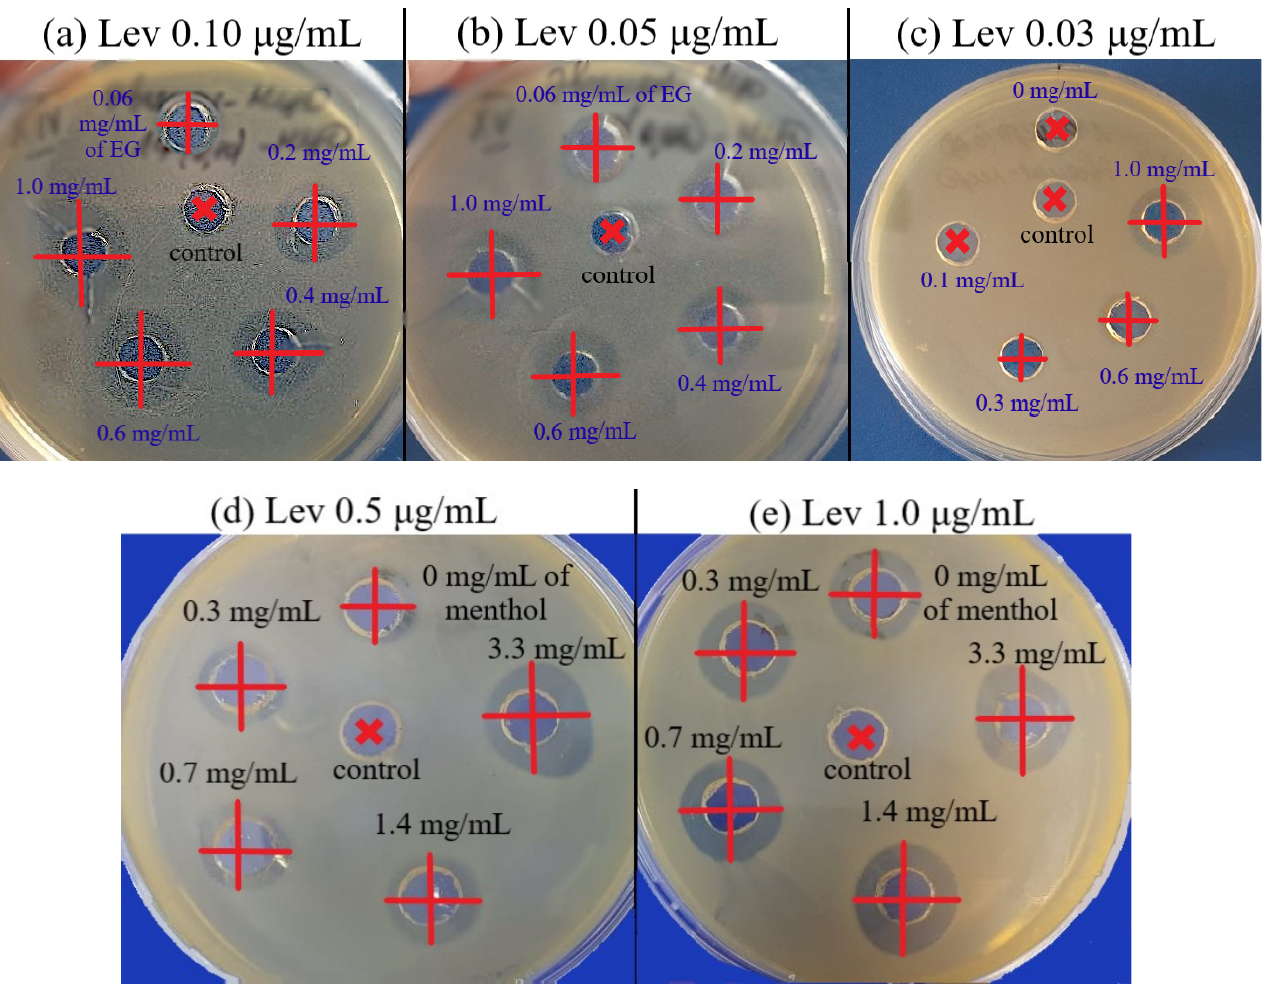
Figure 4 . E. coli growth inhibition by Lev–MCD (1:2), C Lev = 0.10 ( a ); 0.05 ( b ) and 0.03 μ g/mL ( c ) with adjuvant EG–MCD (1:2, the concentrations of EG are indicated in the figure). B. subtilis growth inhibition by Lev–MCD (1:2), C Lev = 0.5 ( d ) and 1.0 ( e ) μ g/mL with adjuvant menthol–MCD (1:2, the concentrations of menthol are indicated in the figure). The molar ratio of the components is given in parentheses. Small bold red crosses refer to the absence of bacterial growth inhibition. Red crosses indicate the diameter of growth inhibition zone. pH 7.4 (0.01 M PBS), 37 °C, 24 h of incubation. MCD: methyl- β -cyclodextrin.